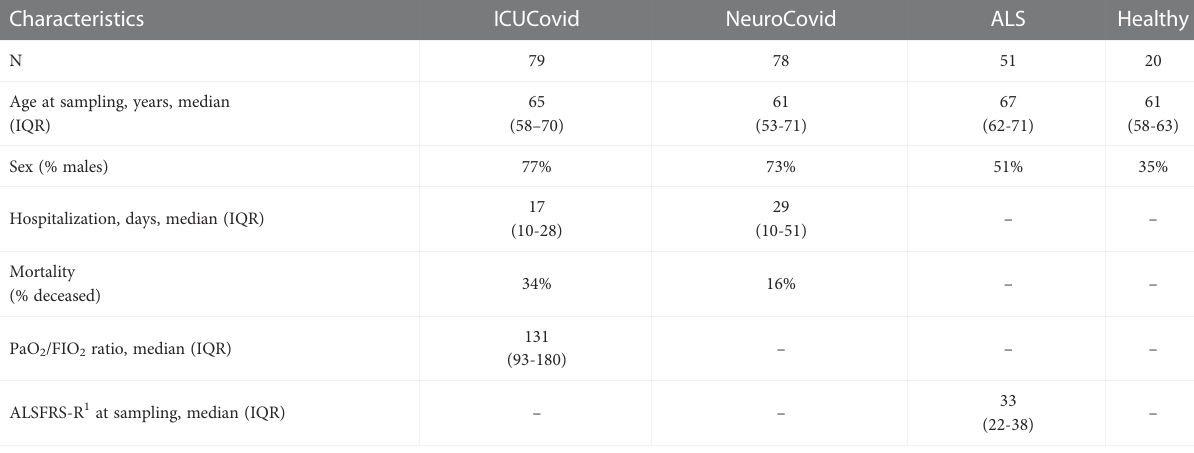
TABLE 1 Demographic and clinical characteristics of the patient